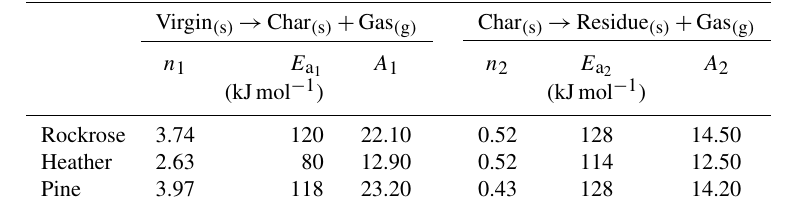
Table 3. Summary of kinetics parameters (Cancellieri et al., 2013).